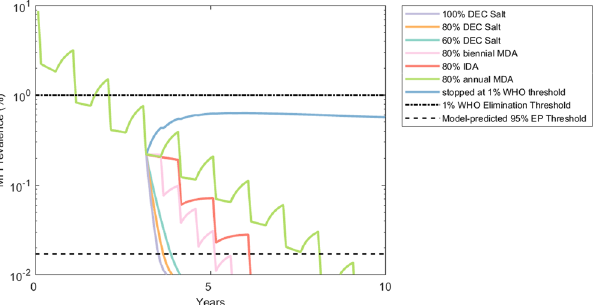
Figure 3. Decline in mf prevalence in Lakshadweep, India, resulting from several different intervention scenarios. The median model-predicted trajectory is shown for each intervention strategy with no background vector control. For the first four years in this simulation, annual MDA at 80% coverage is applied after which one of seven alternative treatment strategies is adopted. The WHO 1% mf threshold and the model-predicted 95% EP threshold are shown as horizontal lines. Note that the y-axis is given in log-scale to better visualize transitions to low prevalence